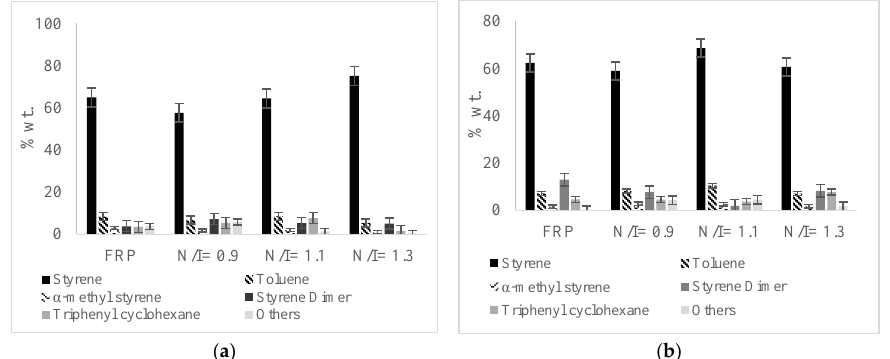
Figure 4. Composition of the liquid fraction in % wt. relative to the fed polymer at different pyrolysis temperatures: ( a ) 390 °C, ( b ) 420 °C. Table 3. Yields of liquid, gas, and solids fractions in the pyrolysis reactions of FRP-PS and NMP-PS and reaction times.